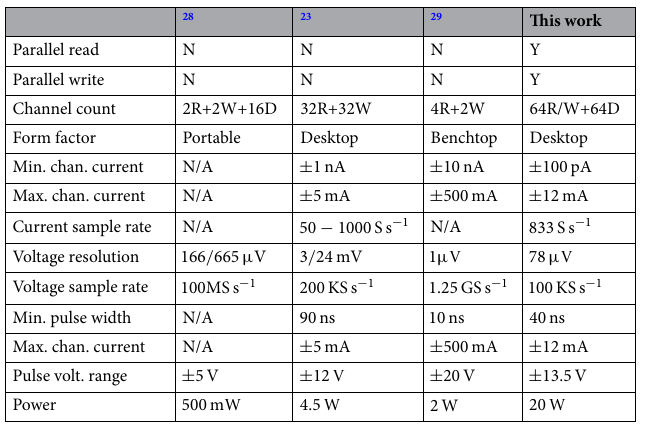
Table 2. Comparison between this work and similar